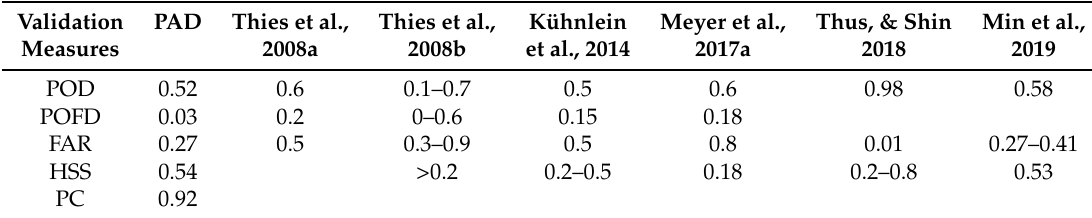
Table 8. Comparison of the validation measures of the new precipitation area delineation (PAD) compared to other